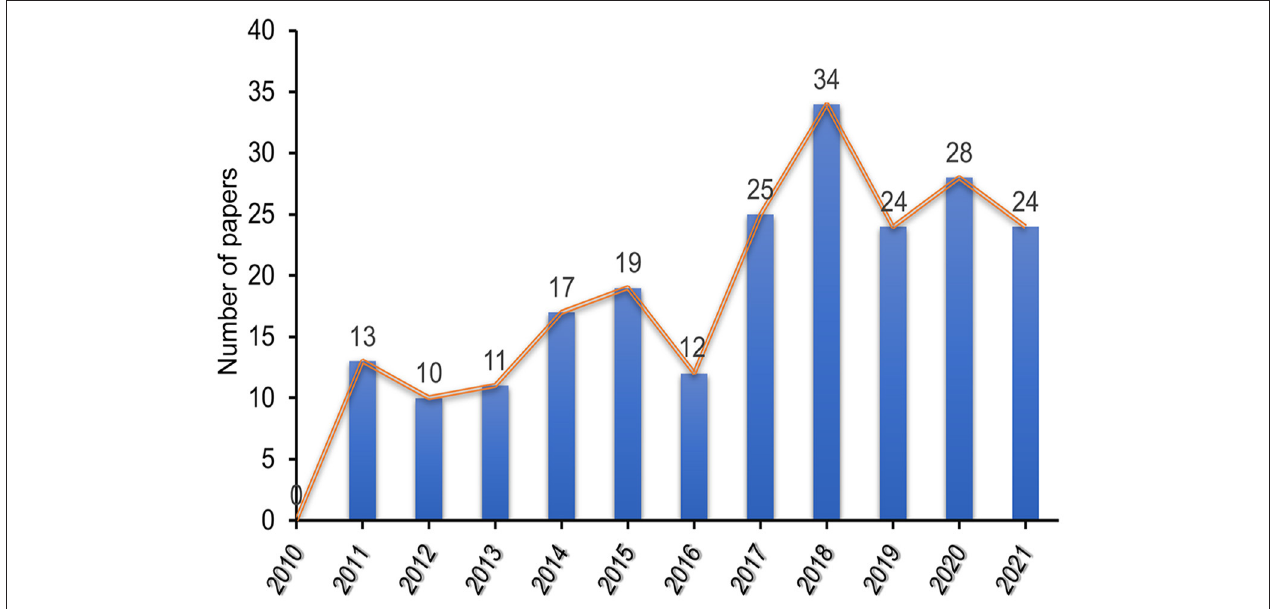
FIGURE 2 | Annual trend chart of publications included in WoS database from 2010 to 2021.